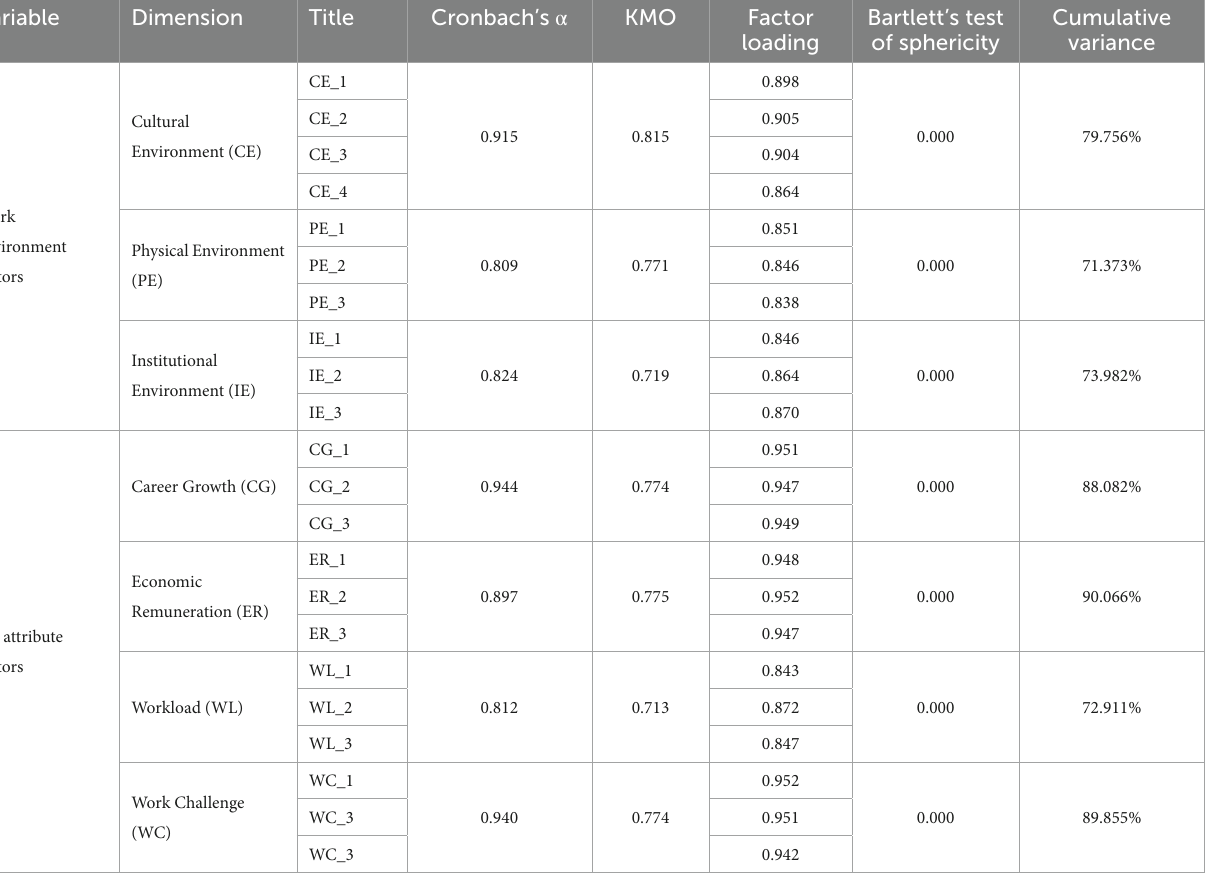
TABLE 3 Reliability and validity analysis ( N =